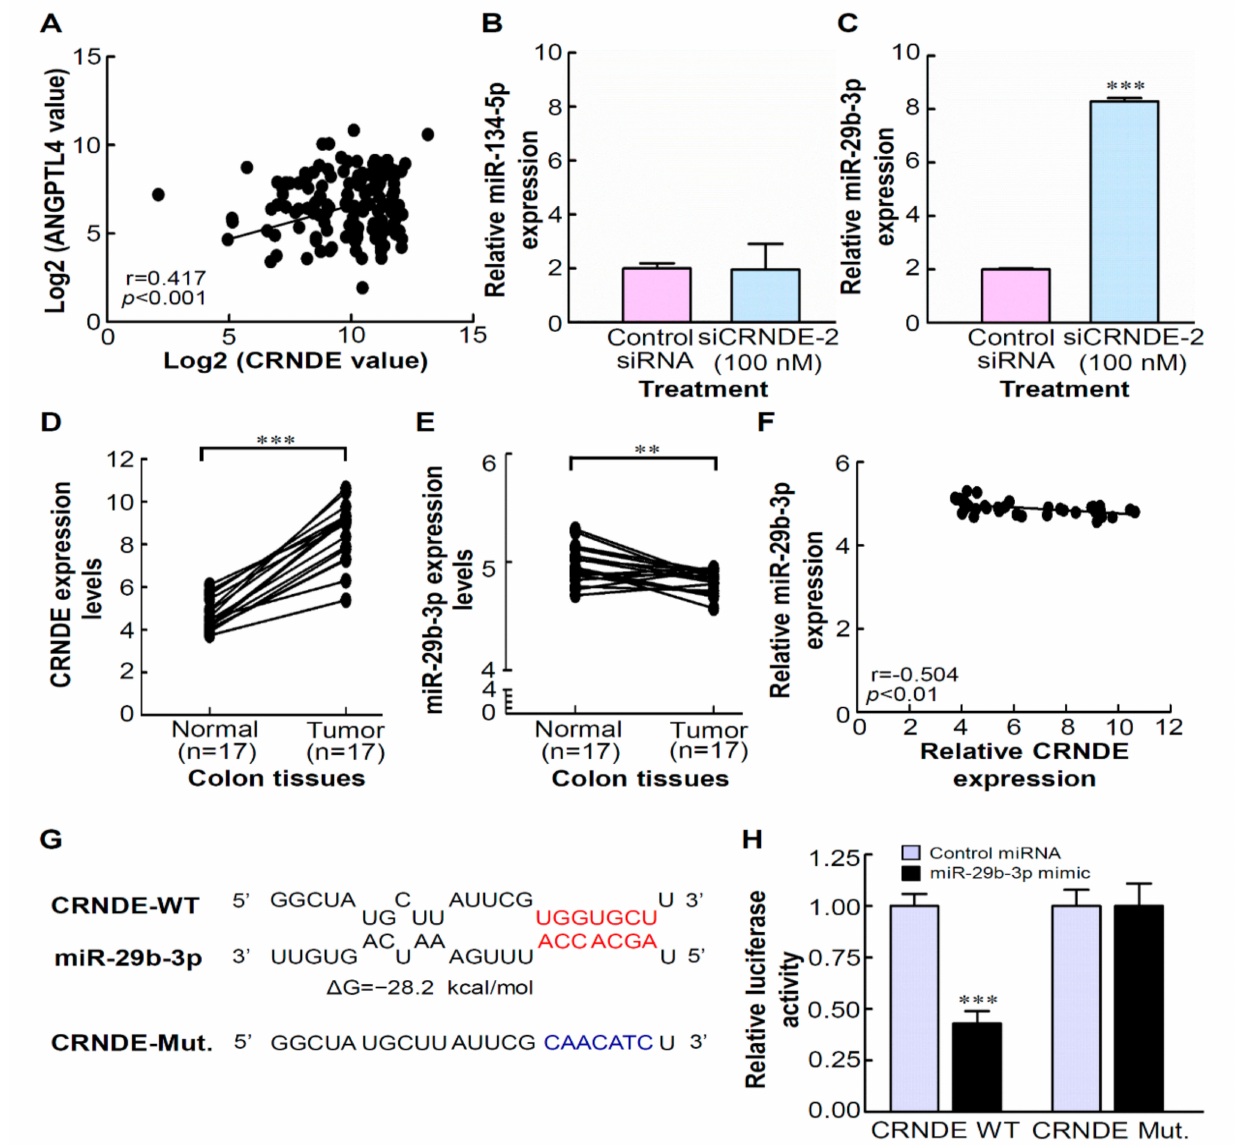
Figure 6. Colorectal neoplasia differentially expressed (CRNDE) directly interacts with miR-29b-3p. ( A ) Correlation analysis revealed the positive relationship between CRNDE and angiopoietin-like 4 (ANGPTL4) expressions in 132 colorectal cancer (CRC) tumor tissues. MiR-134-5p ( B ) and miR-29b-3p ( C ) expressions were determined by an RT-qPCR in CRNDE- knockdown HCT-116 cells. Expressions of CRNDE ( D ) and miR-29b-3p ( E ) in 17 normal/tumor (NT) pairs of CRC resected tumor (T) tissues and corresponding adjacent non-tumor (N) tissues obtained from a public GEO dataset (GSE32323). ( F ) Correlation analysis revealed a negative relationship between CRNDE and miR-29b-3p expressions in 34 cases of NT pairs of CRC tissues from the GEO dataset (GSE32323). ( G ) A bioinformatics analysis revealed predicted binding sites between CRNDE and miR-29b-3p. ( H ) A luciferase reporter assay demonstrated miR-29b-3p mimics significantly decreased the luciferase activity of CRNDE-wild type (WT) in HCT-116 cells, while miR-29b-3p mimics did not affect the luciferase activity of CRNDE-mutant (Mut). ** p < 0.01, *** p <